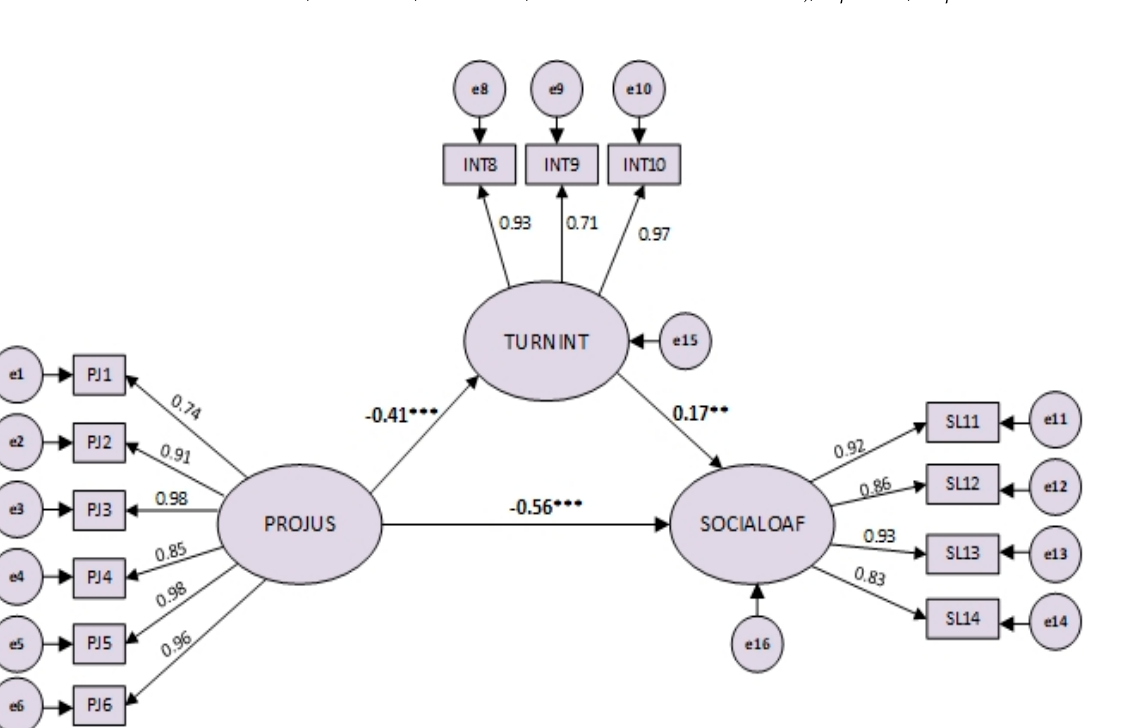
Table 5. Mediation type (developed by the authors).